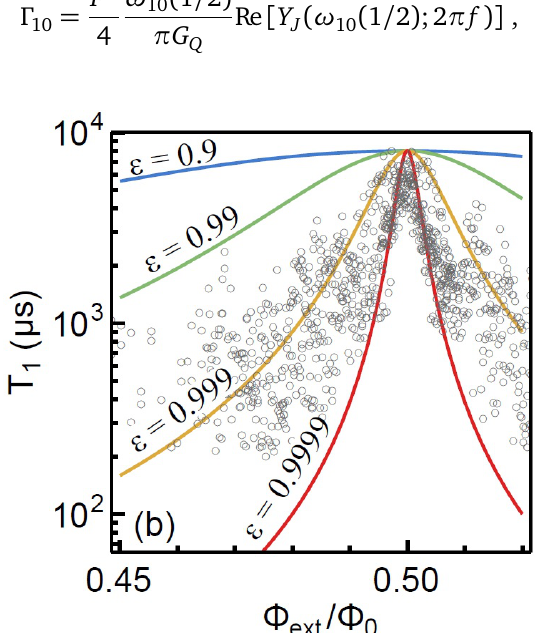
Figure 3: (from Ref. [ 15 ] ) Empty circles: experimental data for T ues of external flux Φ . Solid lines: theoretical rates calculated from Eq. (80) ext ] of Eq. (79), for a few values of (cid:34) and F chosen to bound the data at with Re [ Y J Φ / Φ = 1 / ext 0